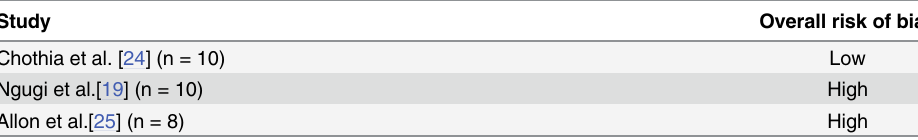
Table 4. Overall risk of bias for randomized